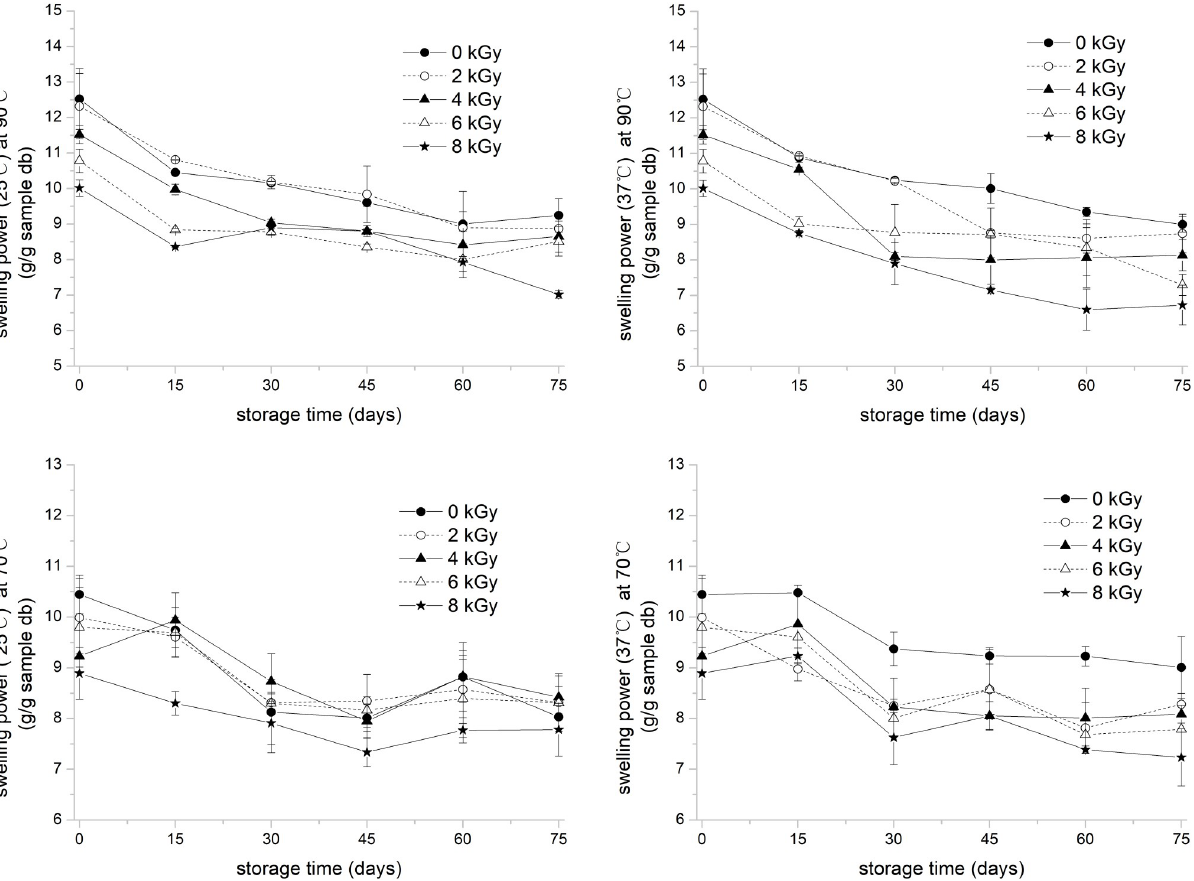
Fig 2. Swelling power changes at 70 ˚C and 90 ˚C of the electronic -beam -irradiated white rice stored at 25 ˚C and 37 ˚C for 75 days of storage. Error bar represents standard deviation ( n = 3).